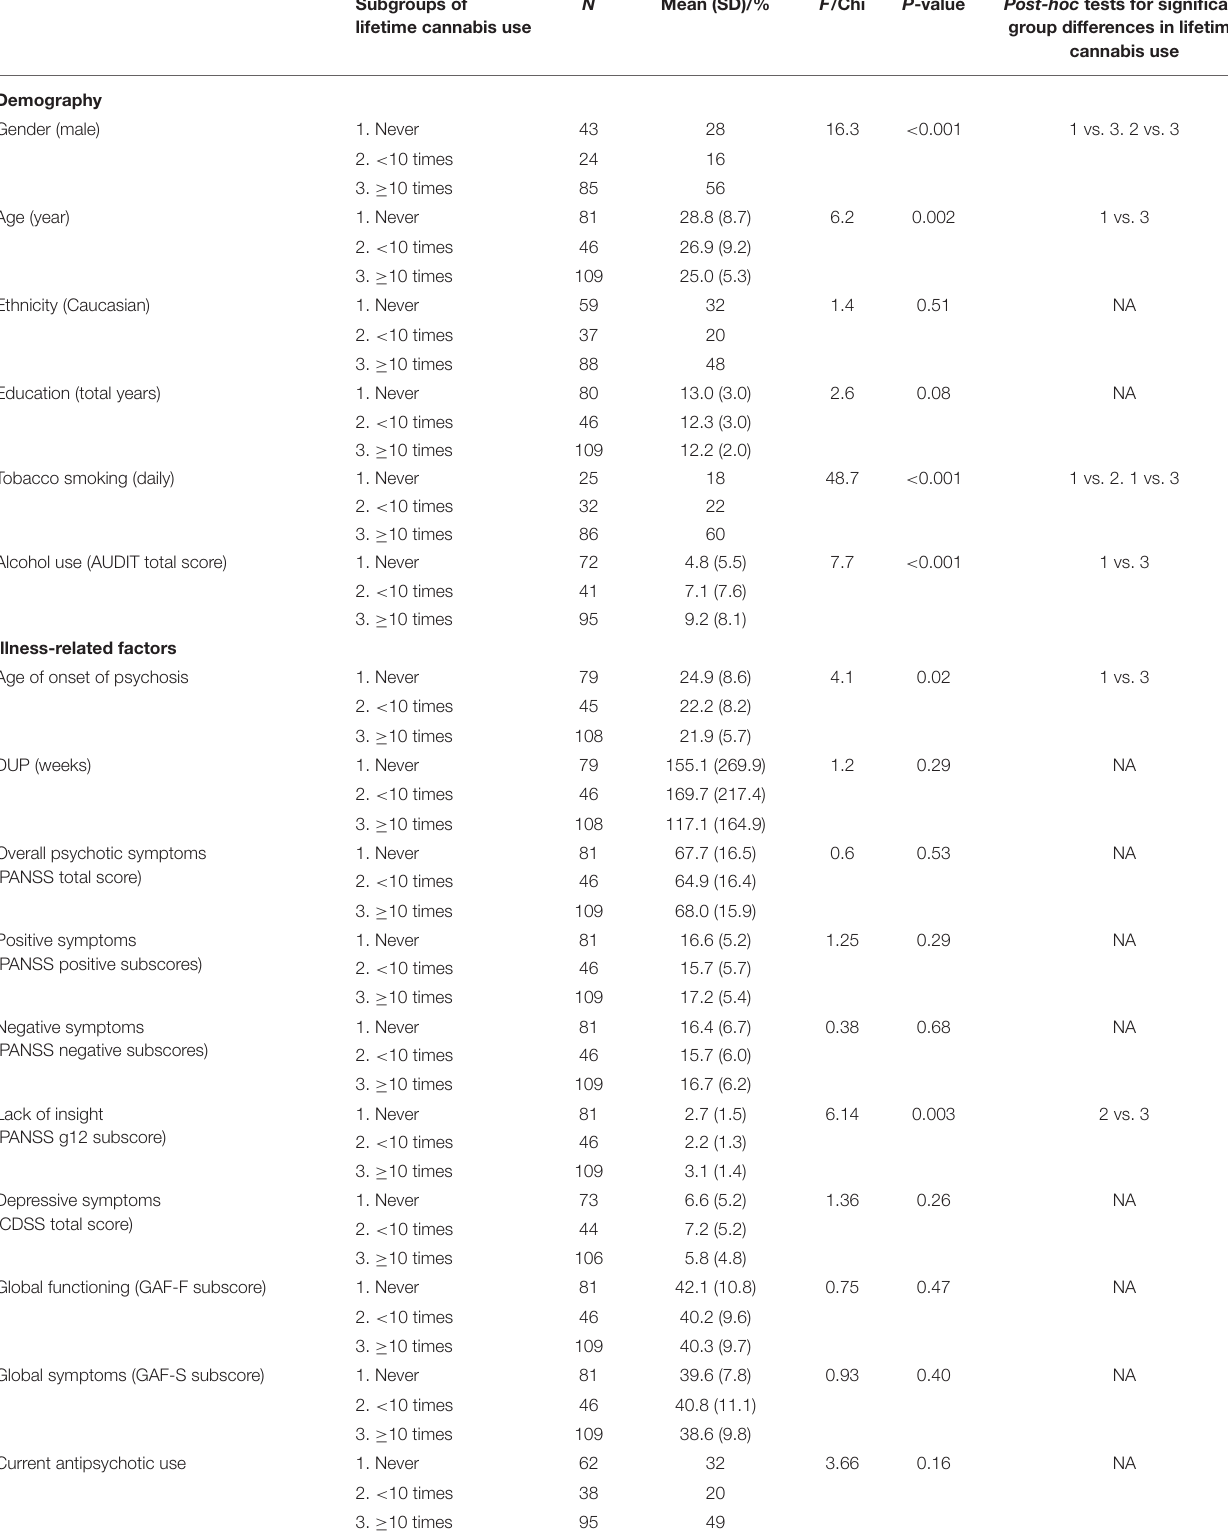
TABLE 3 | Comparison of lifetime cannabis use vs. demography, lifestyle, illness-related factors, and beliefs about medication in FTP patients. N Mean (SD)/% F /Chi P -value Post-hoc tests for significant Subgroups of lifetime cannabis use